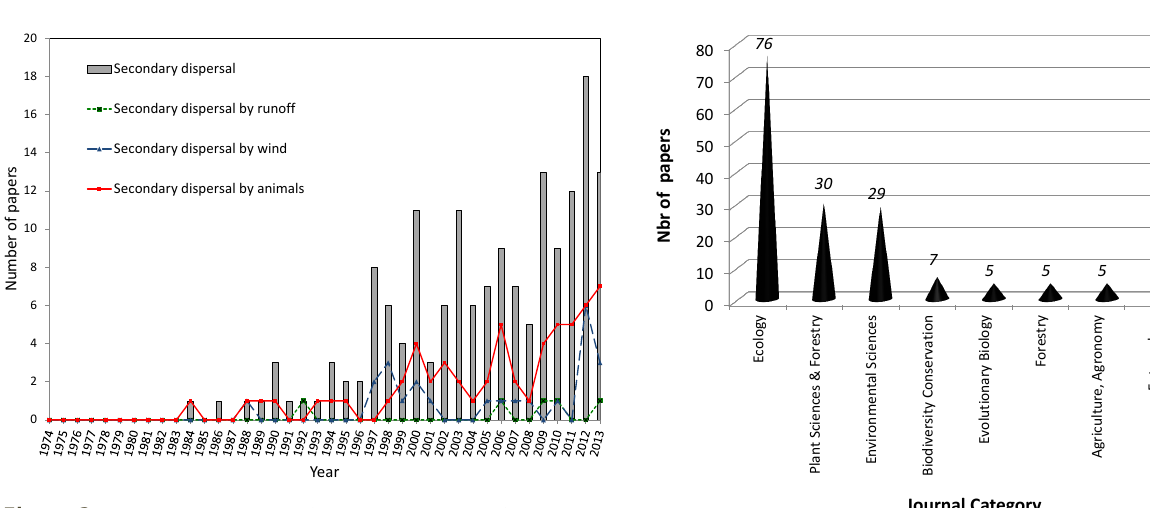
Figure 2. Temporal evolution of the total number of papers on secondary seed dispersal in drylands published between 1974 and 2013, along with the total number of papers for the same time period specifically addressing secondary dispersal by animals, wind and overland flow. Data were obtained from online keyword searches with Scopus database using the “All Document Type” option, date range from 1974 until 2013 and the following formulae in top- ics: (“dispersal” or “seed fate” and “seed”) and (arid or semiarid or semi-arid or dryland or “patchy vegetation” or “patchy ecosys- tem” or patchiness or mosaic or desert) and (“secondary dispersal” or “secondary seed dispersal” or “seed removal” or “seed move- ment” or “secondary seed movement” or “secondary movement” or “secondary process” or “post dispersal” or “post-dispersal” or “seed bank” or “seedbank”), adding (a) (runoff or run-off or erosion or “water transport” or “overland flow”) for overland flow, (b) (wind or eolian) for wind, and (c) (“animal*” or biotic or ants or birds or rodents) for animals.